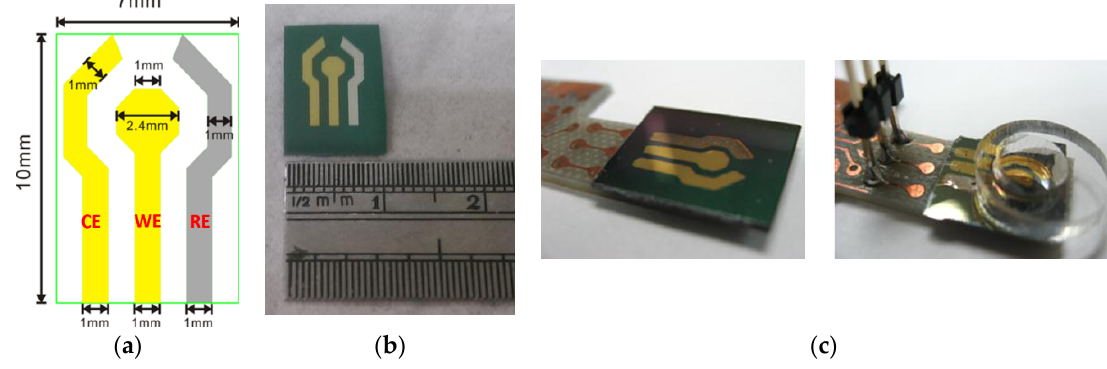
Figure 5. ( a ) Schematic diagram of the proposed urea sensor chip; ( b ) Photo of the urea sensor; ( c ) Photos of the disposable urea sensor integrated with the PCB ( Left ) and PDMS ( Right ).